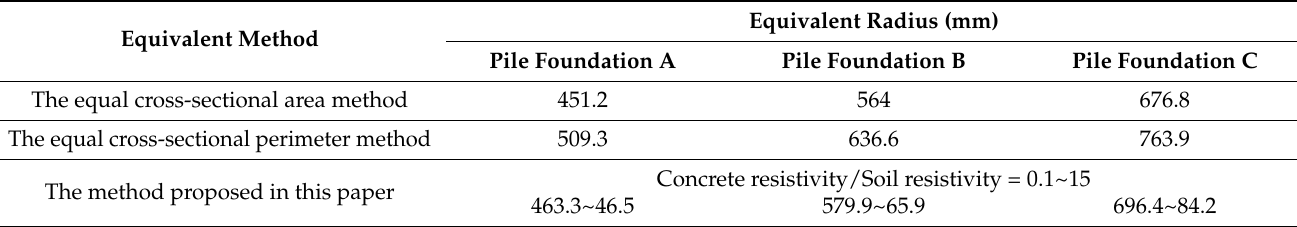
Table 2. Equivalent radius calculated by different methods.